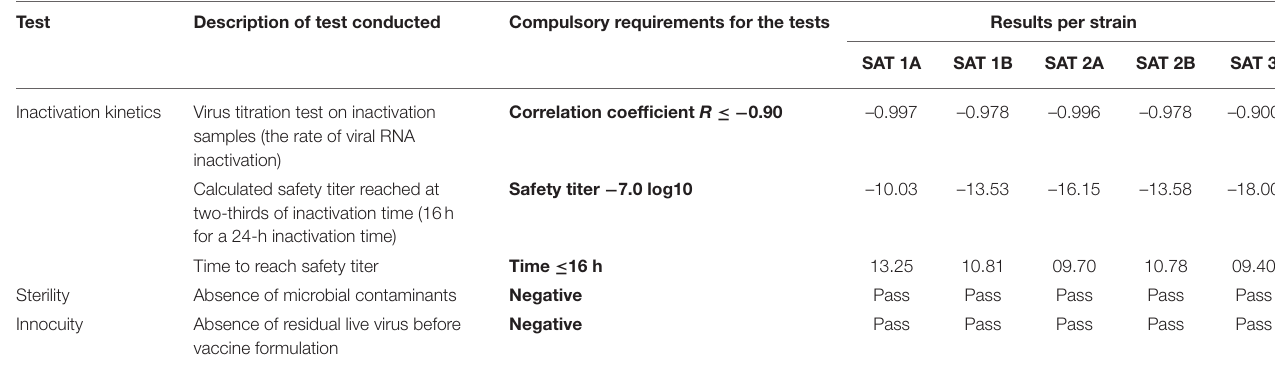
TABLE 2 | A summary QC test results during antigen production for vaccine